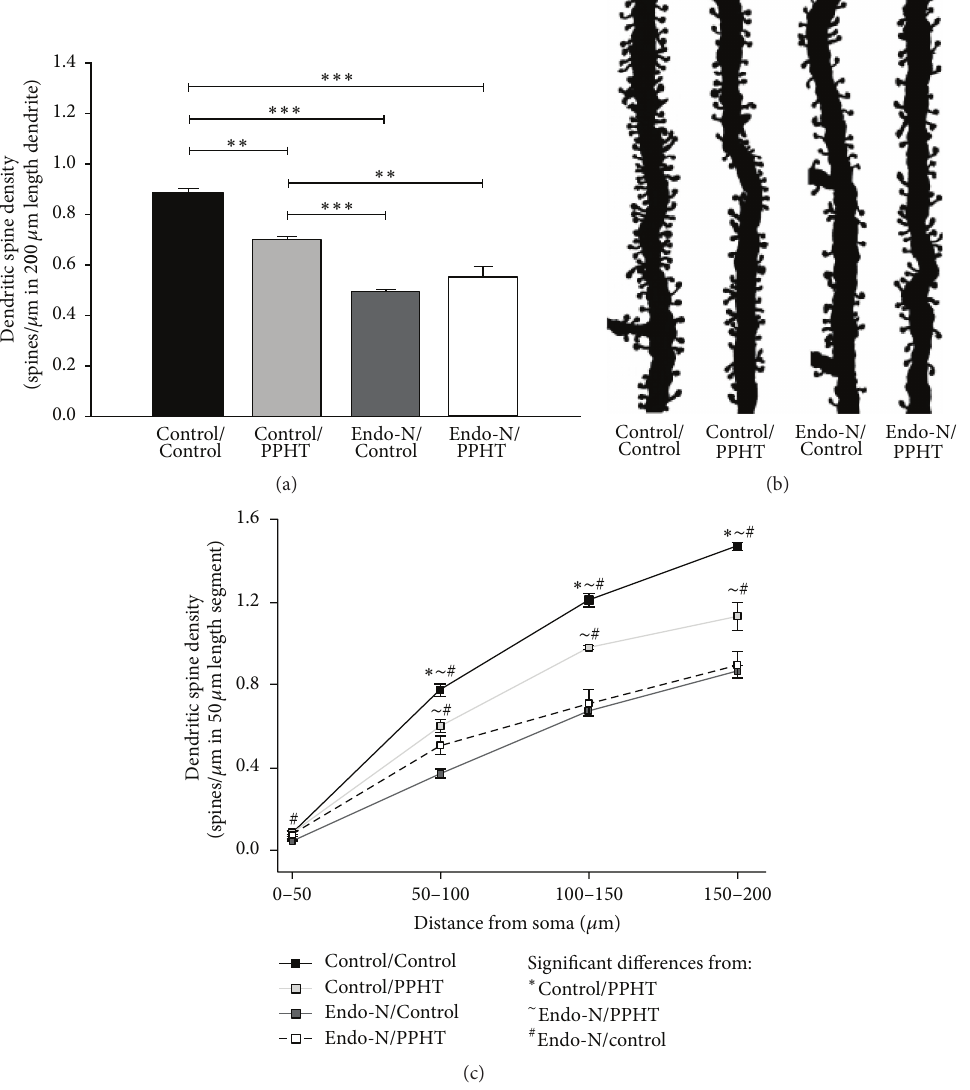
Figure 4: Dendritic spine density in mPFC pyramidal neurons after PPHT or Endo-N treatment and their combination. (a) Graph showing statistically significant differences between groups ( 𝑛 = 6 animals/group) when considering the total length (200 𝜇 m) of the measured dendrites. (b) Camera lucida drawings of 50 𝜇 m length dendritic segments located 150–200 𝜇 m distal from the soma in dorsal cingulate cortex (Cg1), layer III. Note the decreased number of dendritic spines in all treated groups when compared with Control/Control group. (c) Graph representing dendritic spine density as a function of distance from the soma in 50 𝜇 m length segments ( 𝑛 = 6 animals/group). Error bars represent SEM and symbols in bars indicate statistically significant differences between groups (see graph legend) after one-way ANOVA followed by Bonferroni’s correction. For graph (a), ∗ 𝑝 < 0.05 , ∗∗ 𝑝 < 0.01 , and ∗∗∗ 𝑝 < 0.001 . For graph (c), please see 𝑝 values in